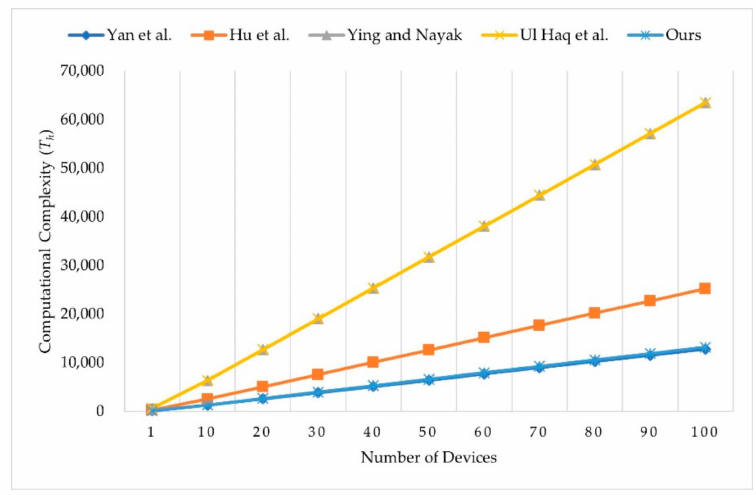
Figure 8. Computational complexity of receiver/gateway node with varying number of